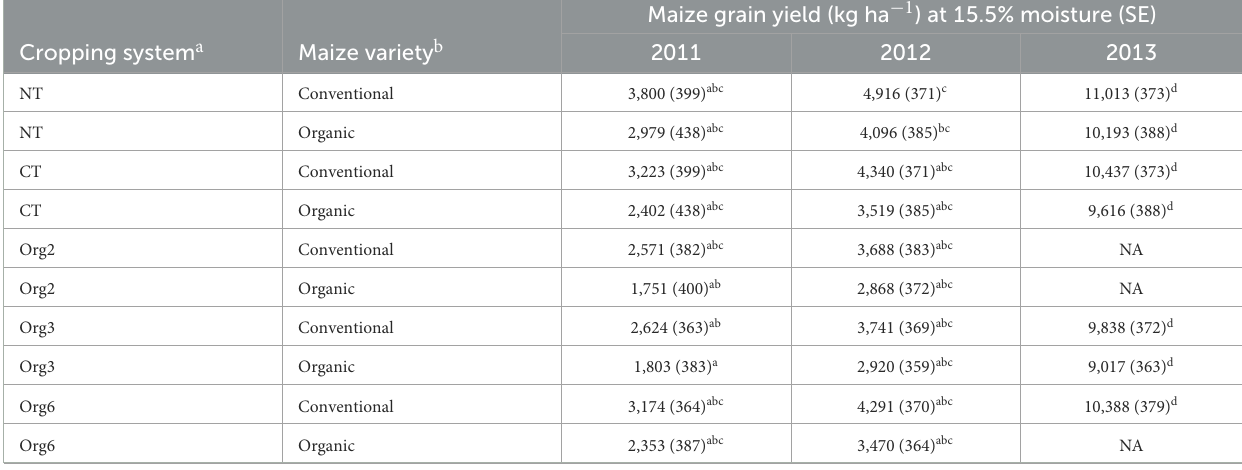
TABLE 3 Stepwise selected model mean and standard error (SE) estimates of maize grain yields in 2011, 2012, and 2013 in FSP microplots (see text); multiple comparison letters ( α = 0.01) following the SE apply across all 3 years. Data were not taken for some microplots in 2013